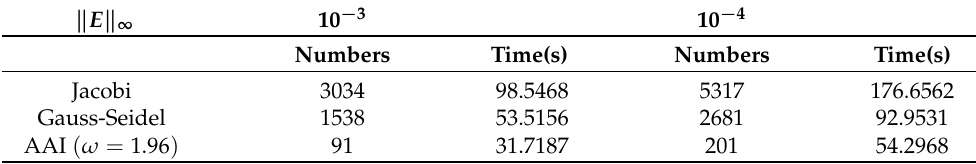
Table 8. The iteration numbers and time(s) of Jacobi, Gauss-Seidel and the AAI algorithm under the different error controls when l = m = s = 71, h =